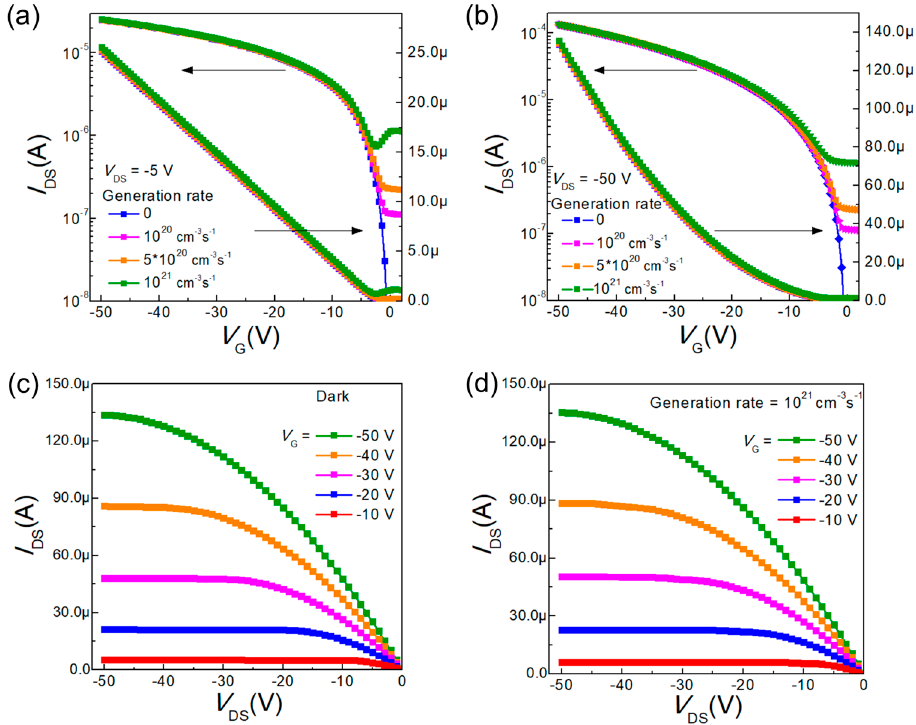
Figure 2. Simulated transfer curve characteristics ( a , b ) and output characteristics ( c , d ) of a TFT device under various photogeneration rates.